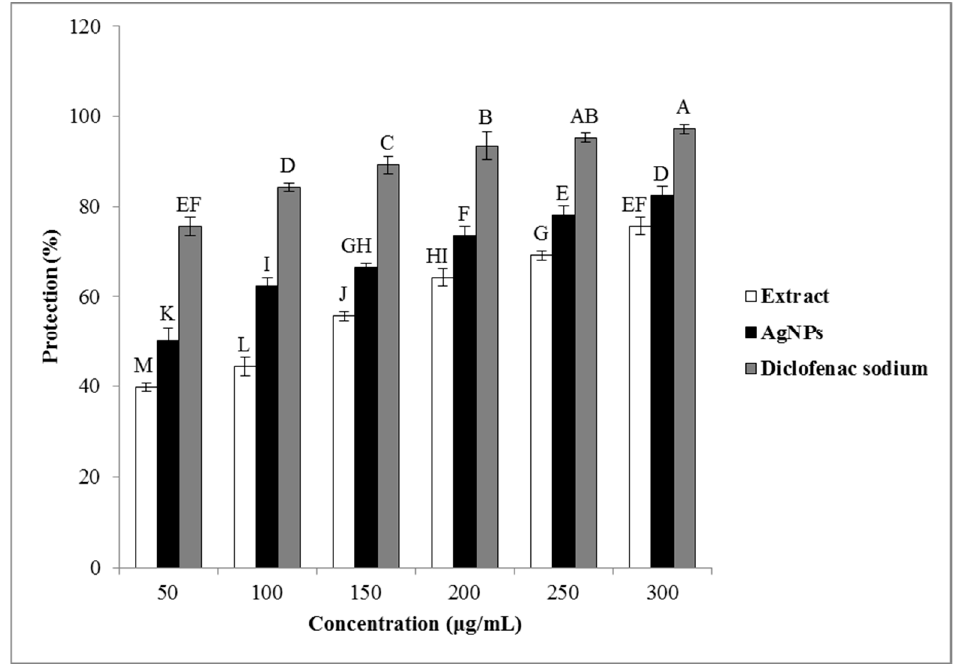
Figure 8. The anti-inflammatory activity of the O. persica leaf extract and the phytofabricated AgNPs. Various letters denote significant differences among the treatments based on the Duncan’s test ( p < 0.05).